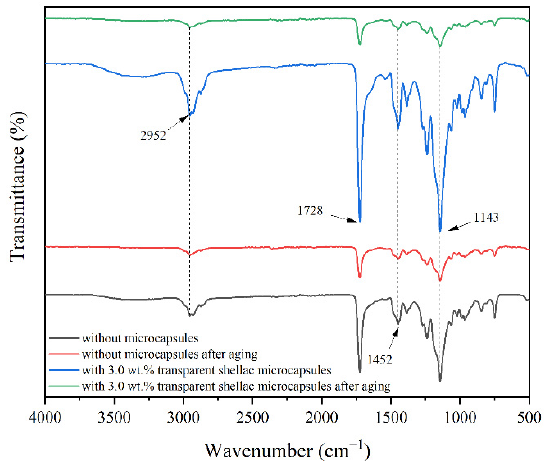
15 of 24 Figure 6. SEM of coatings with different shellac microcapsules after aging: ( A ) 0 microcapsules; ( B ) 3.0 wt.% transparent shellac microcapsules; ( C ) 6.0 wt.% transparent shellac microcapsules; ( D ) 3.0 wt.% transparent purple microcapsules; ( E ) 6.0 wt.% purple shellac microcapsules; ( F ) 3.0 wt.% yel- low shellac microcapsules; ( G ) 6.0 wt.% yellow shellac microcapsules. Figure 7 indicates the infrared spectrum of surface coatings on Beli wood without microcapsules and with 3.0 wt.% transparent shellac microcapsules before and after ag- ing. The infrared spectra of surface coatings on Beli wood with 3.0 wt.% purple shellac